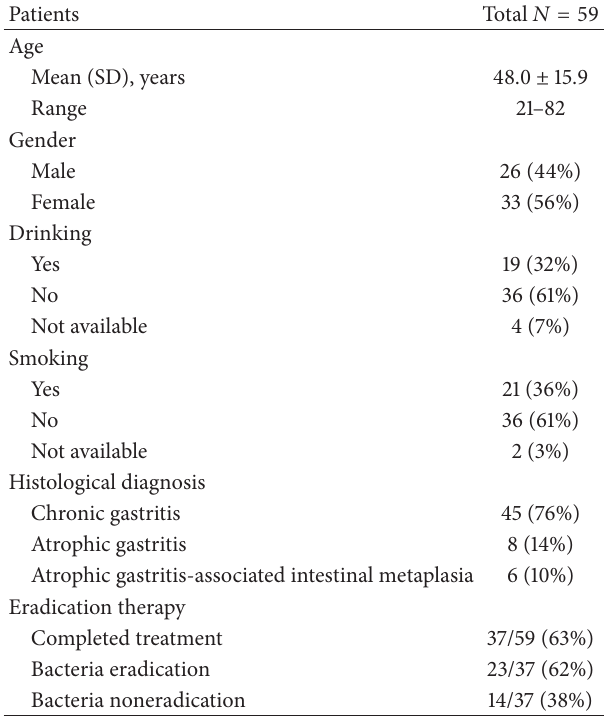
Table 1: Demographic and clinicopathological data of H. pylori - positive patients with chronic